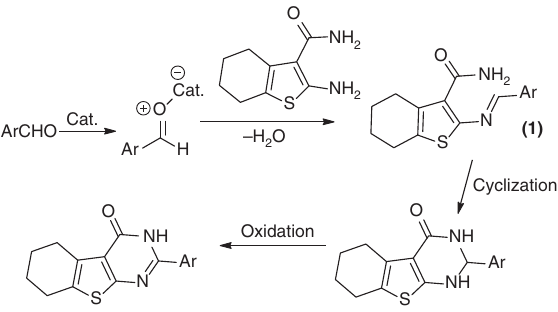
Scheme 1: Proposed mechanism for the synthesis of thieno[2,3- d ] pyrimidin-4(3 H )-one derivatives.